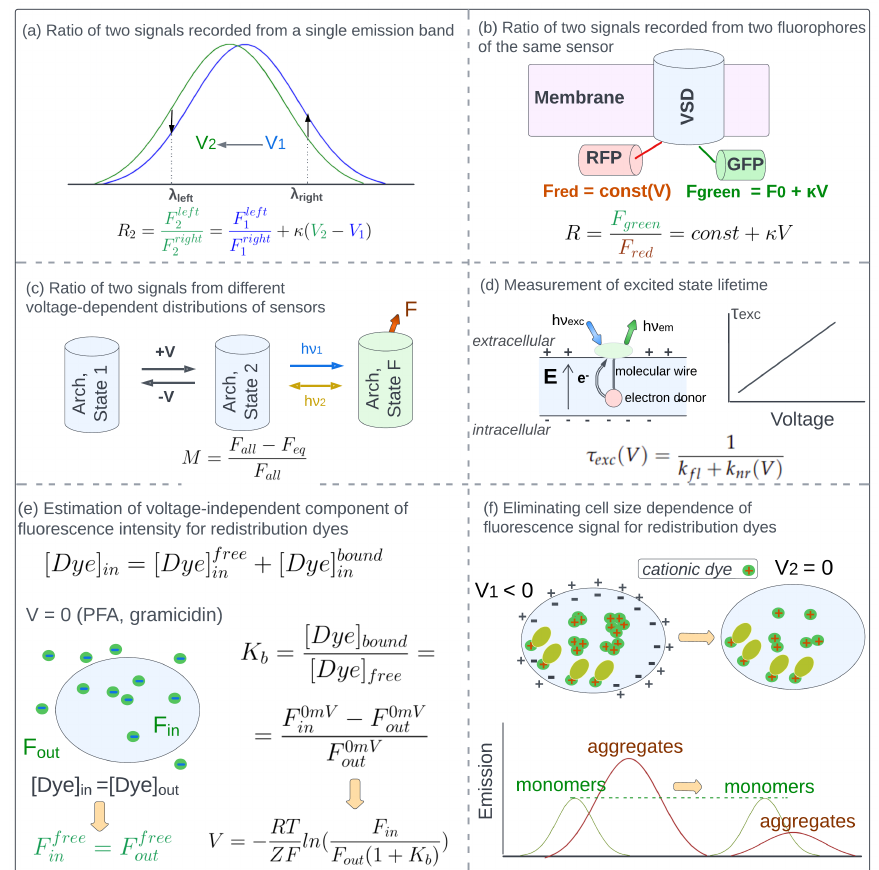
Figure 2. Elimination of fluorescence changes caused by factors other than voltage. ( a ) Ratio of two signals recorded from a single emission band. The voltage-induced shift of the emission band of electrochromic dyes results in the opposite changes of emission intensities corresponding to wavelengths at the left and right wings of the band. The ratio of fluorescence intensities at two wavelengths from the left and right wings of the emission band does not depend on sensors concentration and was shown to be linearly dependent on voltage [31,107]. ( b ) Ratio of two signals recorded from two fluorophores of the same sensor. Sensor is constructed as a fusion of a voltage- sensitive domain (VSD) and two fluorescent proteins—green (GFP) and red (RFP). Voltage-dependent structural reorganization of VSD is passed to FPs, resulting in linear fluorescence voltage-dependence of GFP. The fluorescence intensity of RFP remains voltage-independent. The ratio of two signals can be used to cancel out concentration dependence [28,106]. ( c ) Ratio of two signals from different voltage- dependent distributions of sensors. Microbial rhodopsin Arch D95H demonstrates linear fluorescence response to membrane potential changes attributed to the voltage-dependent equilibrium between the fluorescent (F) and non-fluorescent states of the protein [114]. In the proposed protocol the whole population of sensors was converted into state F with blue light illumination and the corresponding fluorescence intensity F all was measured. Afterward, orange light was used to establish an equilibrium with voltage-dependent concentration of state F, and the fluorescence intensity F eq was measured. The relative decrease of fluorescence intensity was shown to be a robust concentration-corrected